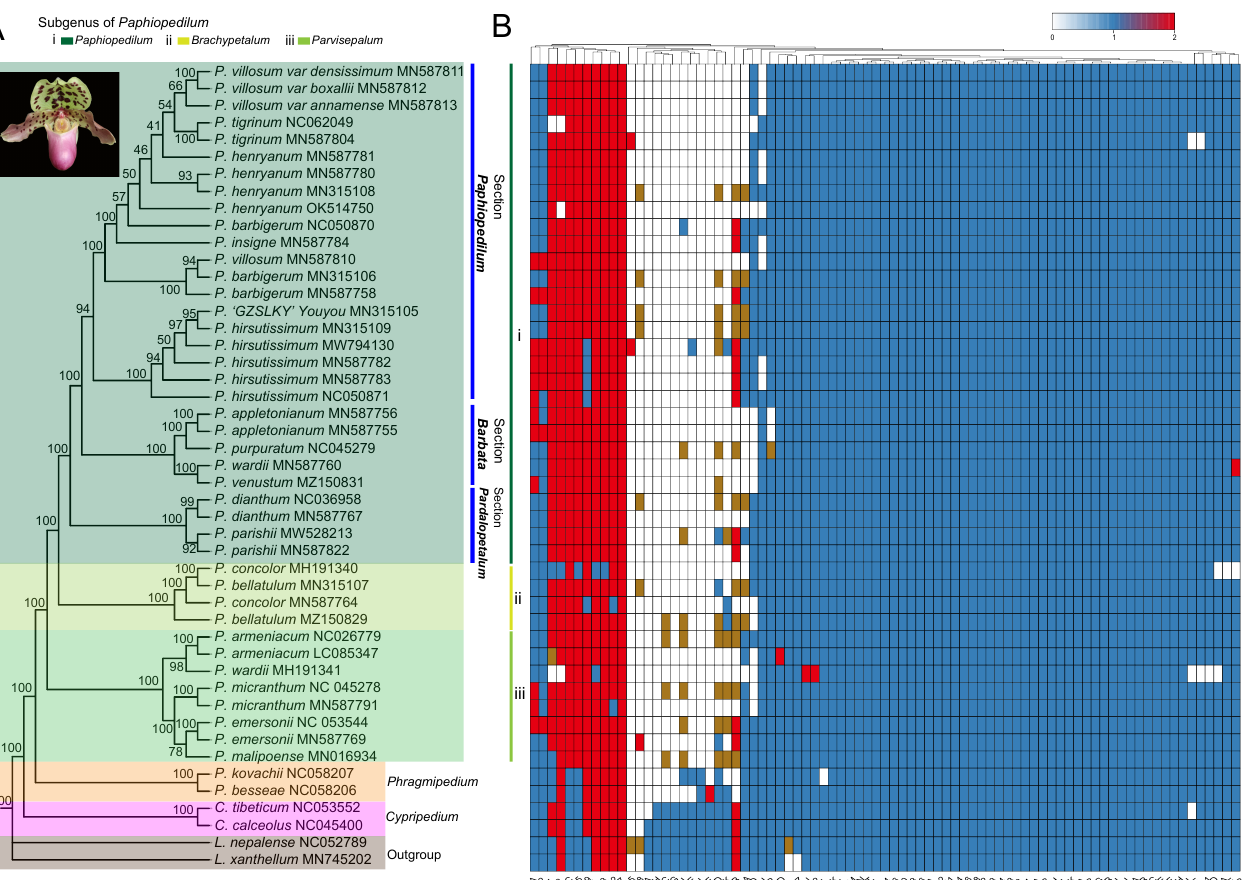
Figure 6. The Maximum Likelihood (ML) phylogeny tree and the heat map of the copy’s numbers in protein coding genes for 47 individuals including 41 Paphiopedilum individuals, two Cypripedium individuals, two Phragmipedium individuals and two Lilium individuals. ( A ) The ML tree of 41 Paphio- pedilum individuals plus 6 taxa constructed by using the whole cp genome sequences. Numbers on nodes of the ML tree indicated bootstrap values. The symbols i, ii, and iii were used to indicate the Subg. Paphiopedilum , Subg. Brachypetalum and Subg. Parvisepalum , respectively. The sections within the Subg. Paphiopedilum were also annotated by using the blue bars. ( B ) The heat map of the numbers of the protein coding genes. Colors reflect the copy numbers of these genes in each species. The pseudogene was colored by brown blocks. The order of the individuals from top to bottom in the heatmap was consist with the ML